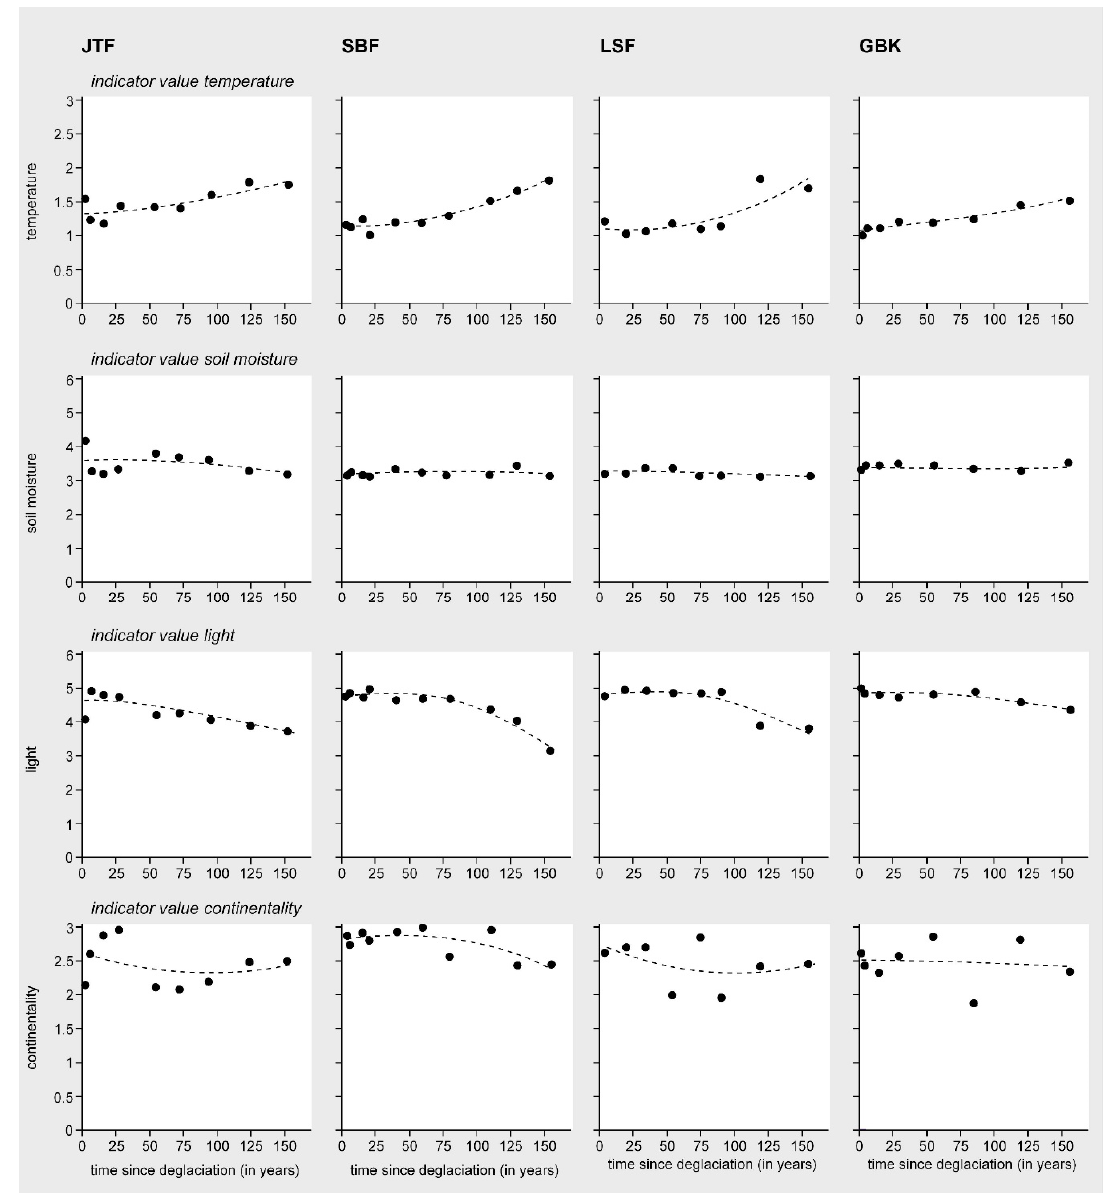
Figure 5. Change of climatic traits scores with time since deglaciation within the four glacier forelands studied. The values are cover-weighted averages of sample locations according to [46,47] .